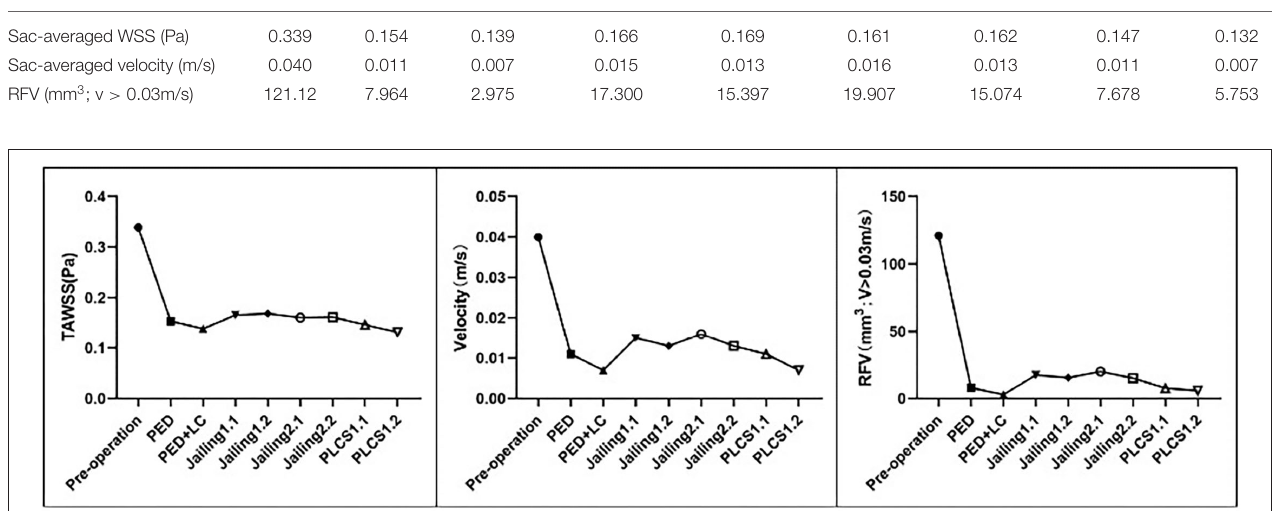
the long-term stability after embolization. Hemodynamic risk parameters – WSS, RFV, and high-velocity regions – were lower for PLCS than those for jailing, thus reducing the recurrence